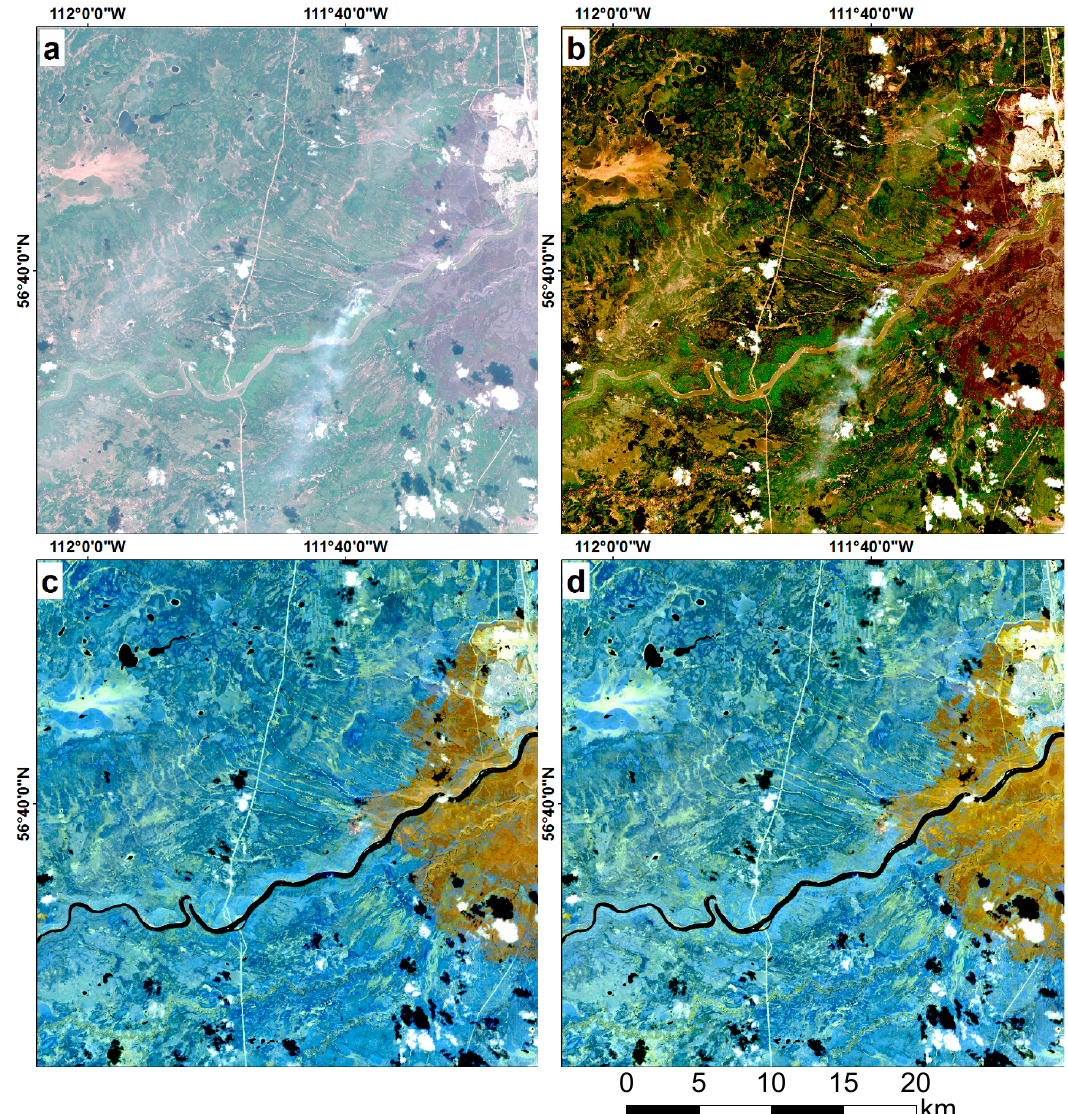
Figure 3. Example 40 × 40 km 2 pixel subset of the second Sentinel-2A MSI Canada image acquisition (12 May 2016) ( a ) true color (b04, b03, b02) 10 m top of atmosphere reflectance; and ( b ) SEN2COR atmospherically corrected equivalent bands displayed with the same logarithmic contrast stretch; ( c ) false color (b12, b11, b8a) 20 m top of atmosphere reflectance; and ( d ) SEN2COR atmospherically corrected equivalent bands displayed with the same contrast stretch.